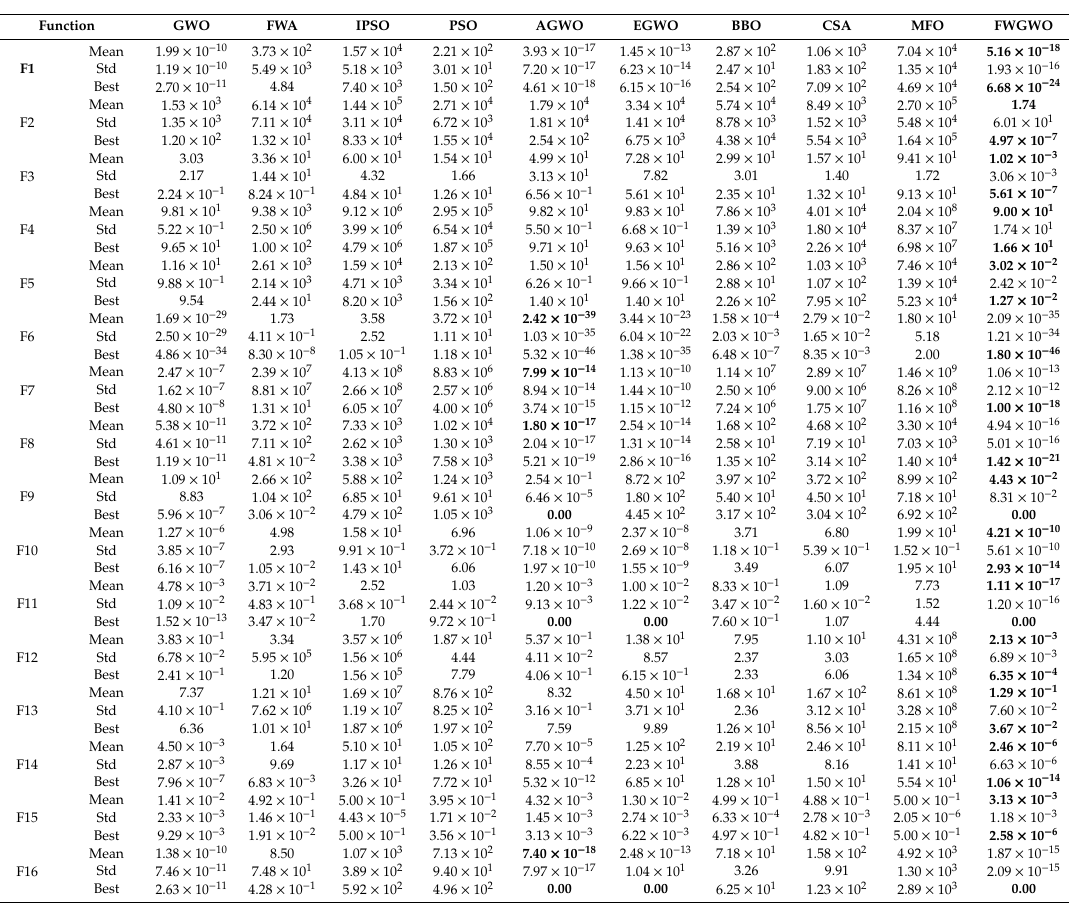
Table 2. Results of the benchmark